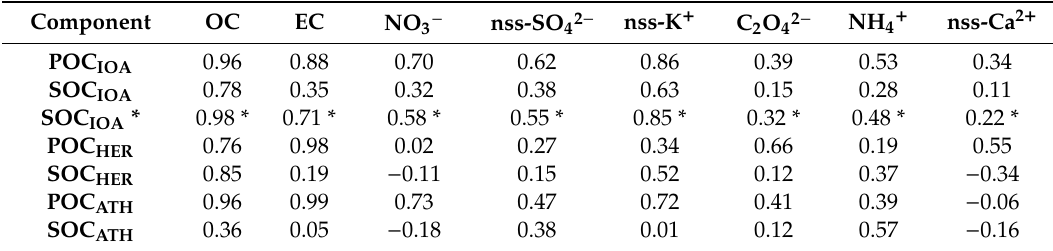
Table 3. Pearson correlation coe ffi cients ( r ) for comparisons of POC and SOC estimated with the MRS method against carbonaceous aerosols and ionic species. The asterisk (*) refers to correlations with SOC 25% in